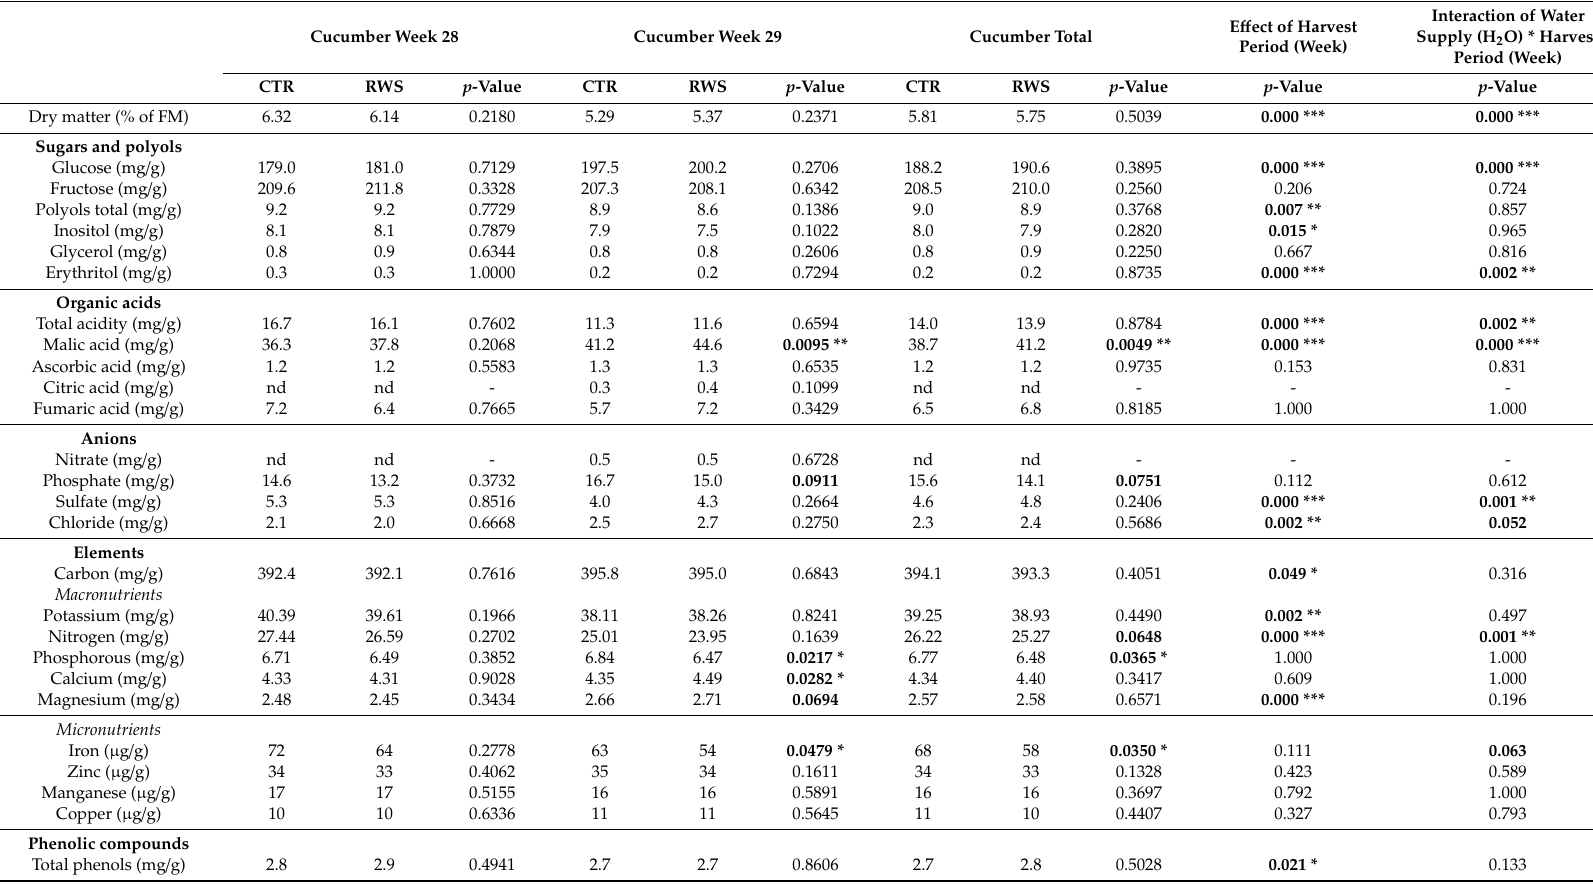
Table 2. Influence of moderate water reduction on the dry matter (DM)-related levels of constituents of cucumber fruits from two harvesting sets (week 28 and week 29) in 2016. Linear mixed model, t-test, p -values: < 0.1, < 0.05 (*), < 0.01 (**) and < 0.001 (***); nd = not determined, CTR: Control treatment with full water supply, RWS: Reduced water supply